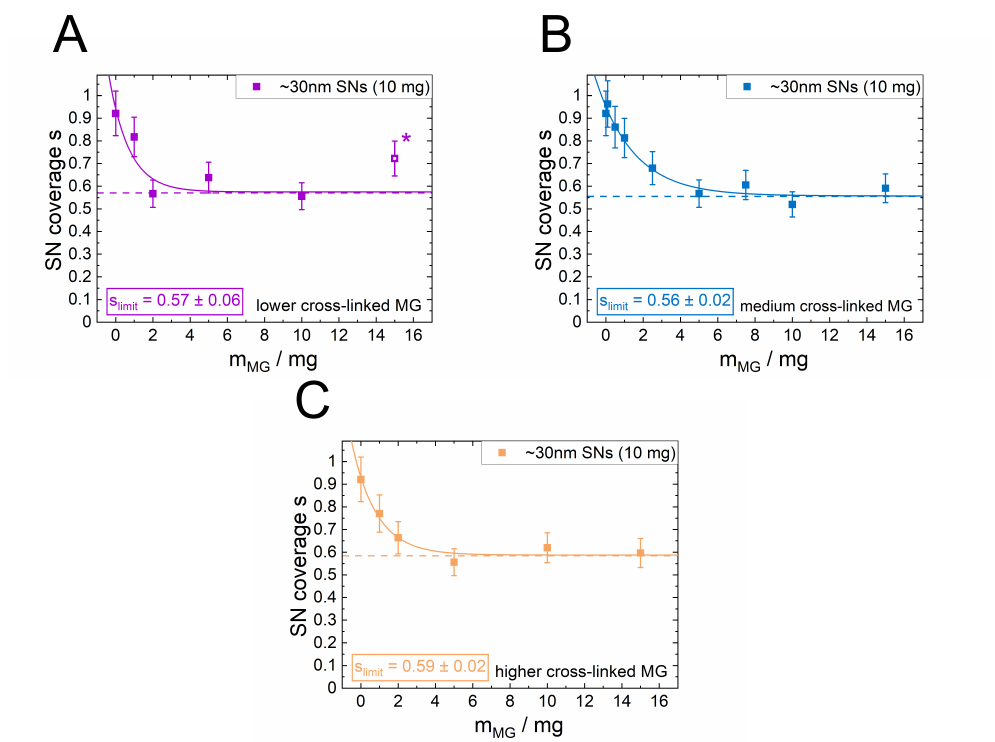
Figure 5. Coverage parameter s of the SNs in SN/MG co-stabilized emulsions calculated from the Sauter mean diameters presented in Figure 3A–C using Equation (5) (average deviation less than 8% for all fits). All three curves run into a saturation for high amounts of MGs. The final SN coverage s limit was determined using Equation (6) and is very similar for all three MG types, irrespectively of the cross-linker